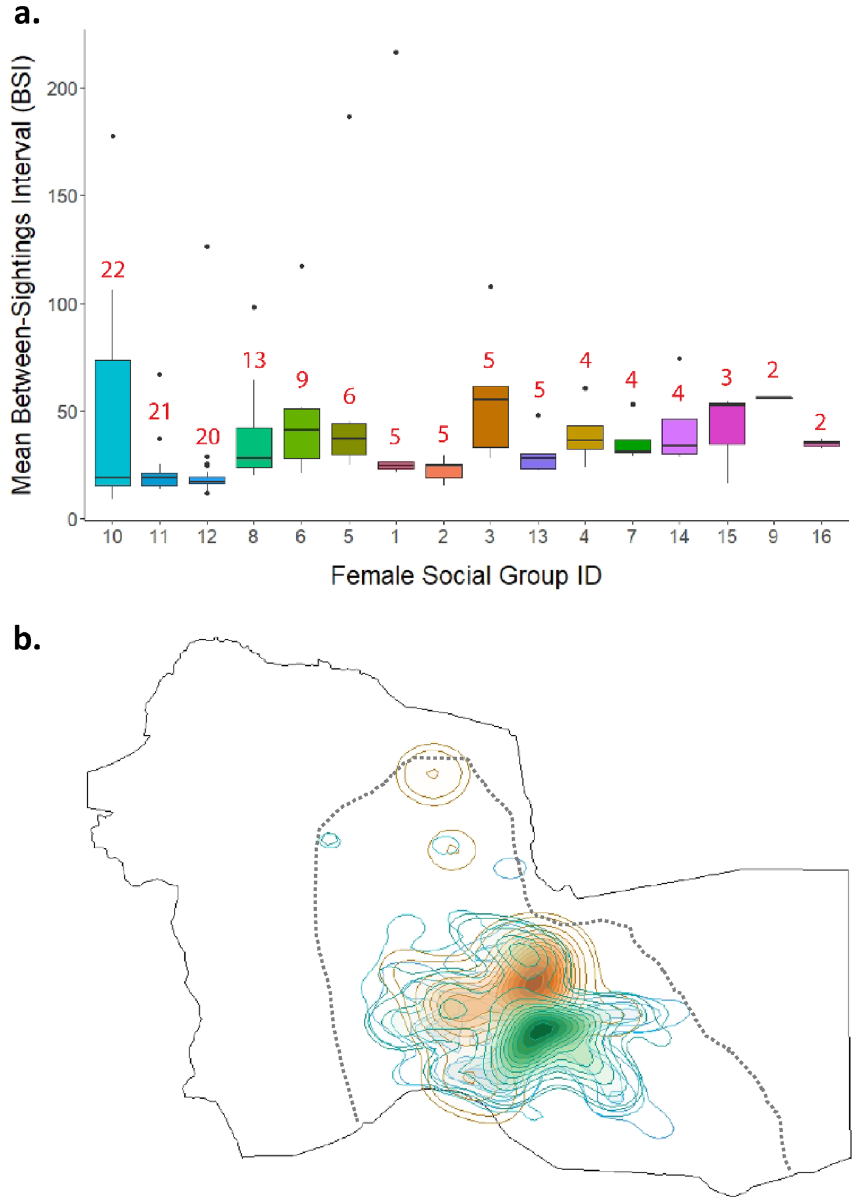
Figure 5. Female BSI and space use. ( a ) Mean between-sightings-interval (BSI) for adult females when individuals are grouped by social assignment. Numbers along the x-axis correspond to community identity (Fig. 4) and are ordered by community size from largest (left, 22 individuals) to smallest (right, 2 individuals). ( b ) Space use for 2 communities with the highest (orange and green, communities 3 and 9) and lowest median BSI (turquoise and blue, communities 10 and 12), illustrate high spatial overlap between putative residents and non-residents within the observation area, defined by the dotted line.